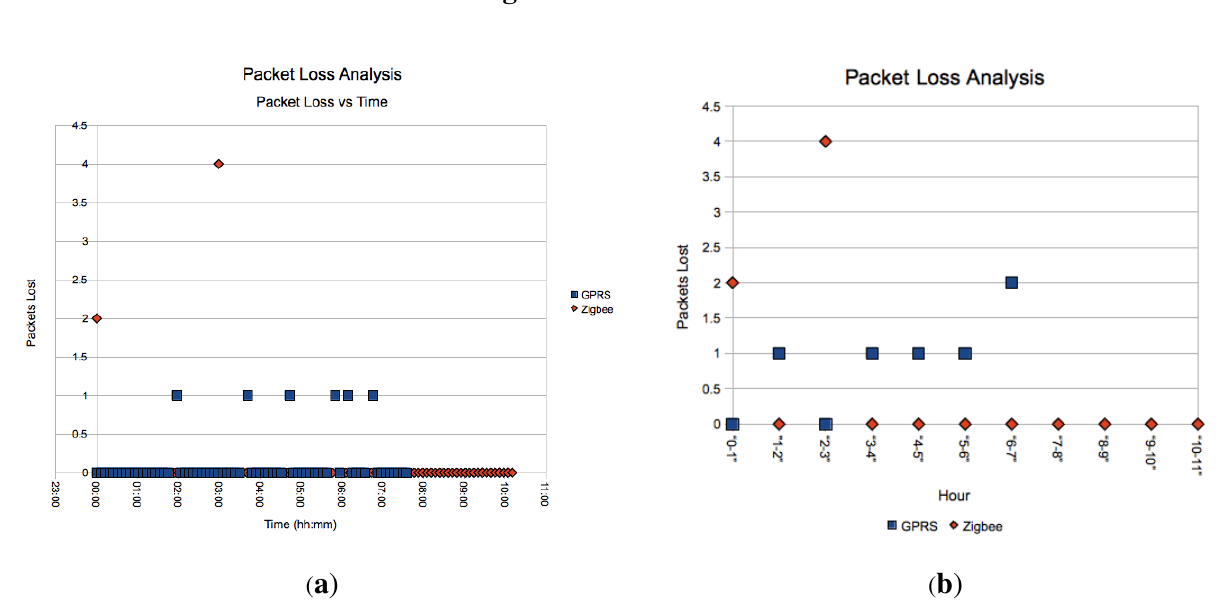
Figure 11. Packet